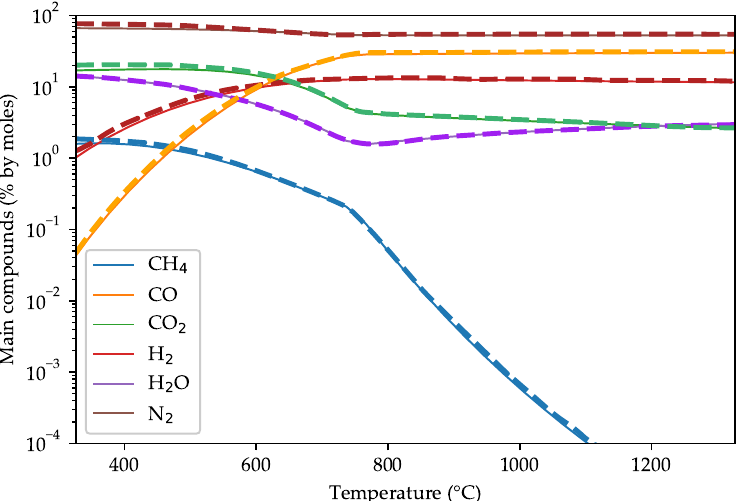
Figure 3. Comparison of the simulated (dashed line) variation of the equilibrium synthesis gas composition with temperature for Highvale coal against the modeling results produced by Li et al. [17] (solid lines) ( p = 0.155 MPa, stoichiometric ratio =